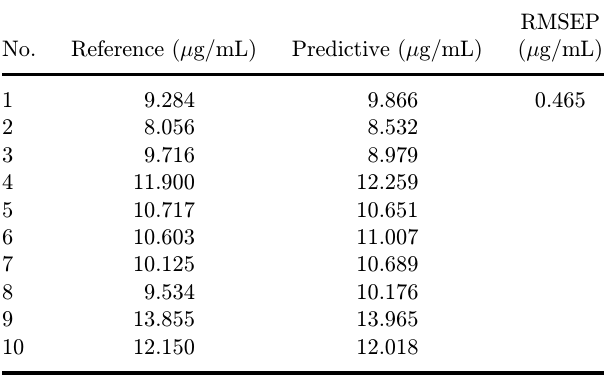
Table 6. Comparison of reference values and predicted values of PLS enamel content